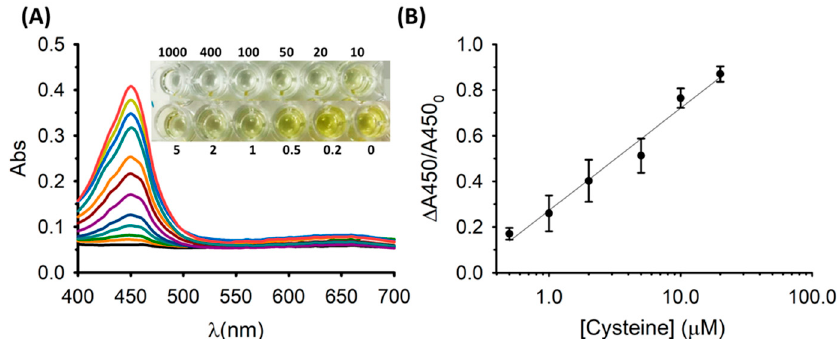
Figure 3. ( A ) Absorption spectra of the proposed assay with different concentrations of cysteine. The inset shows the color responses of iodide-capped AuNPs to different concentrations of cysteine. ( B ) Linear relationship between the normalized absorbance value at 450 nm and the concentration of cysteine in the buffer system.